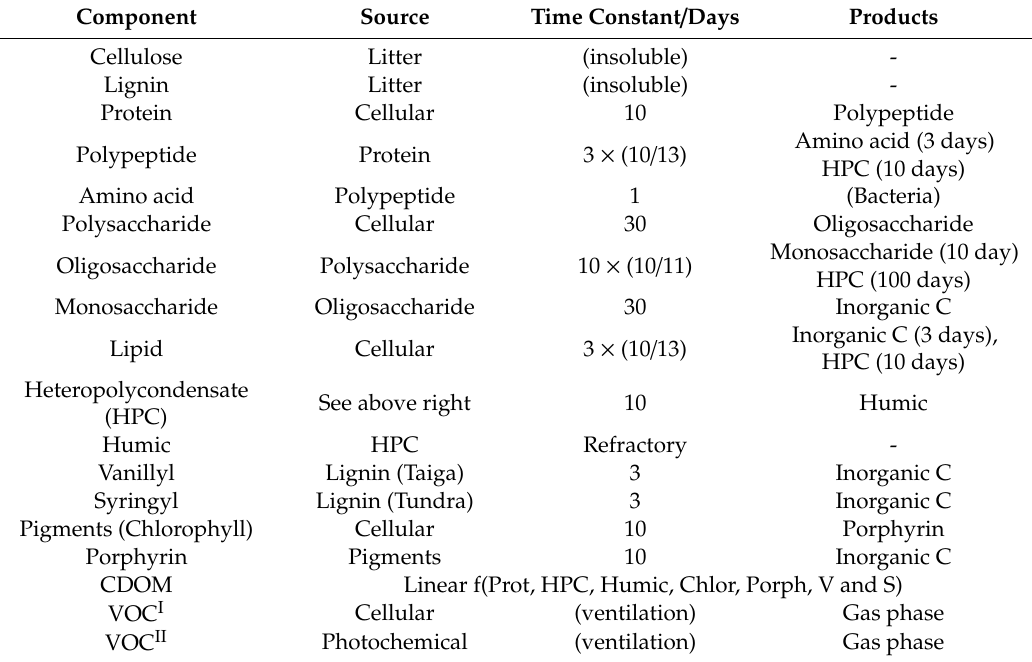
Table 2. River chemical mechanism presented in textual form. Mainly, the rates shown are empirical high latitude marine to coastal values, while others may be relative and taken from rough global concentration relationships. The entire grouping is scaled slower in certain key runs as